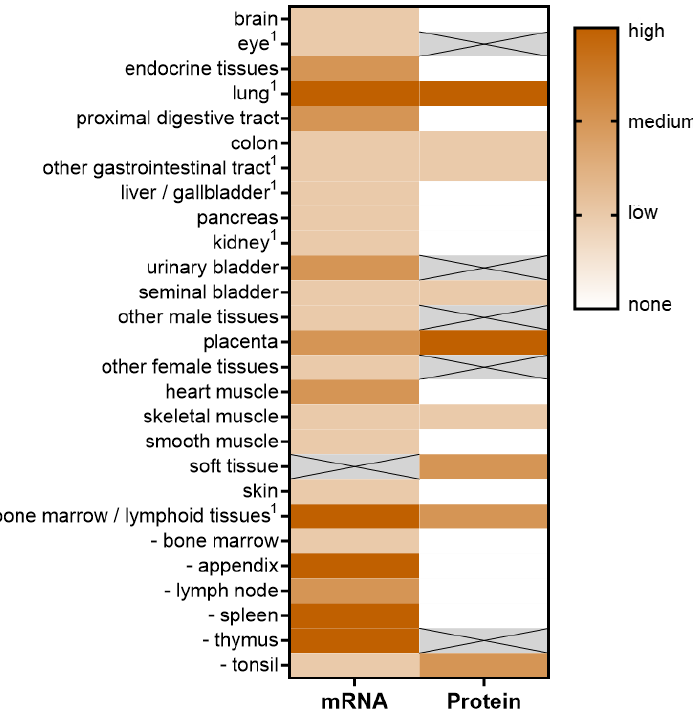
Figure 3. Organ PD-L1 mRNA and protein expression: RNA and protein expression are derived from the Human Protein Atlas (www.proteinatlas.org, accessed on 1 July 2022) [69,70]. The RNA expression summary is based on normalized expression (nTPM) values. Crossed-out gray cells indicate no available data. 1 Some authors identified a different organ expression, please refer to the main text.